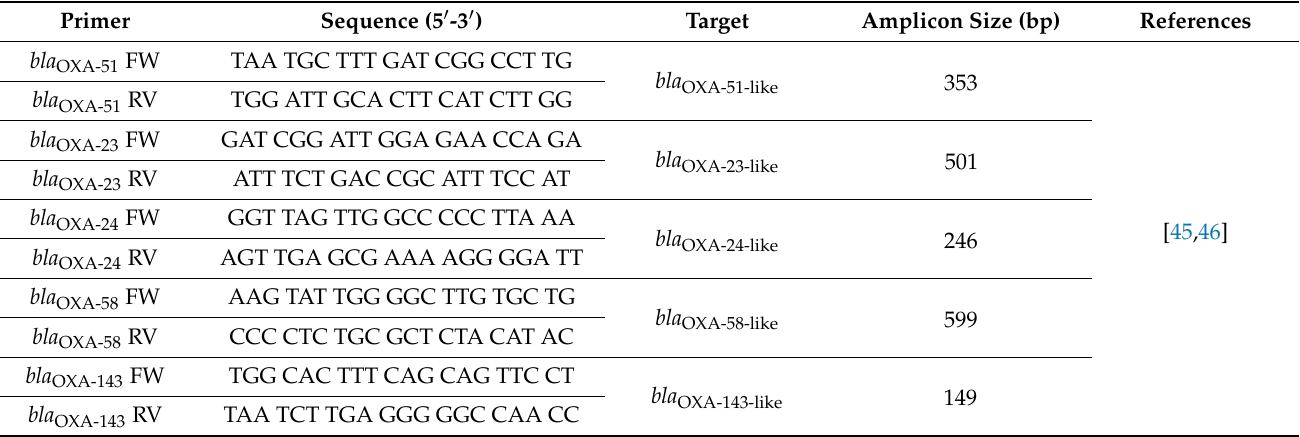
Table 2. Primers used for PCR amplification of oxacillinase resistance genes ( bla OXA-like